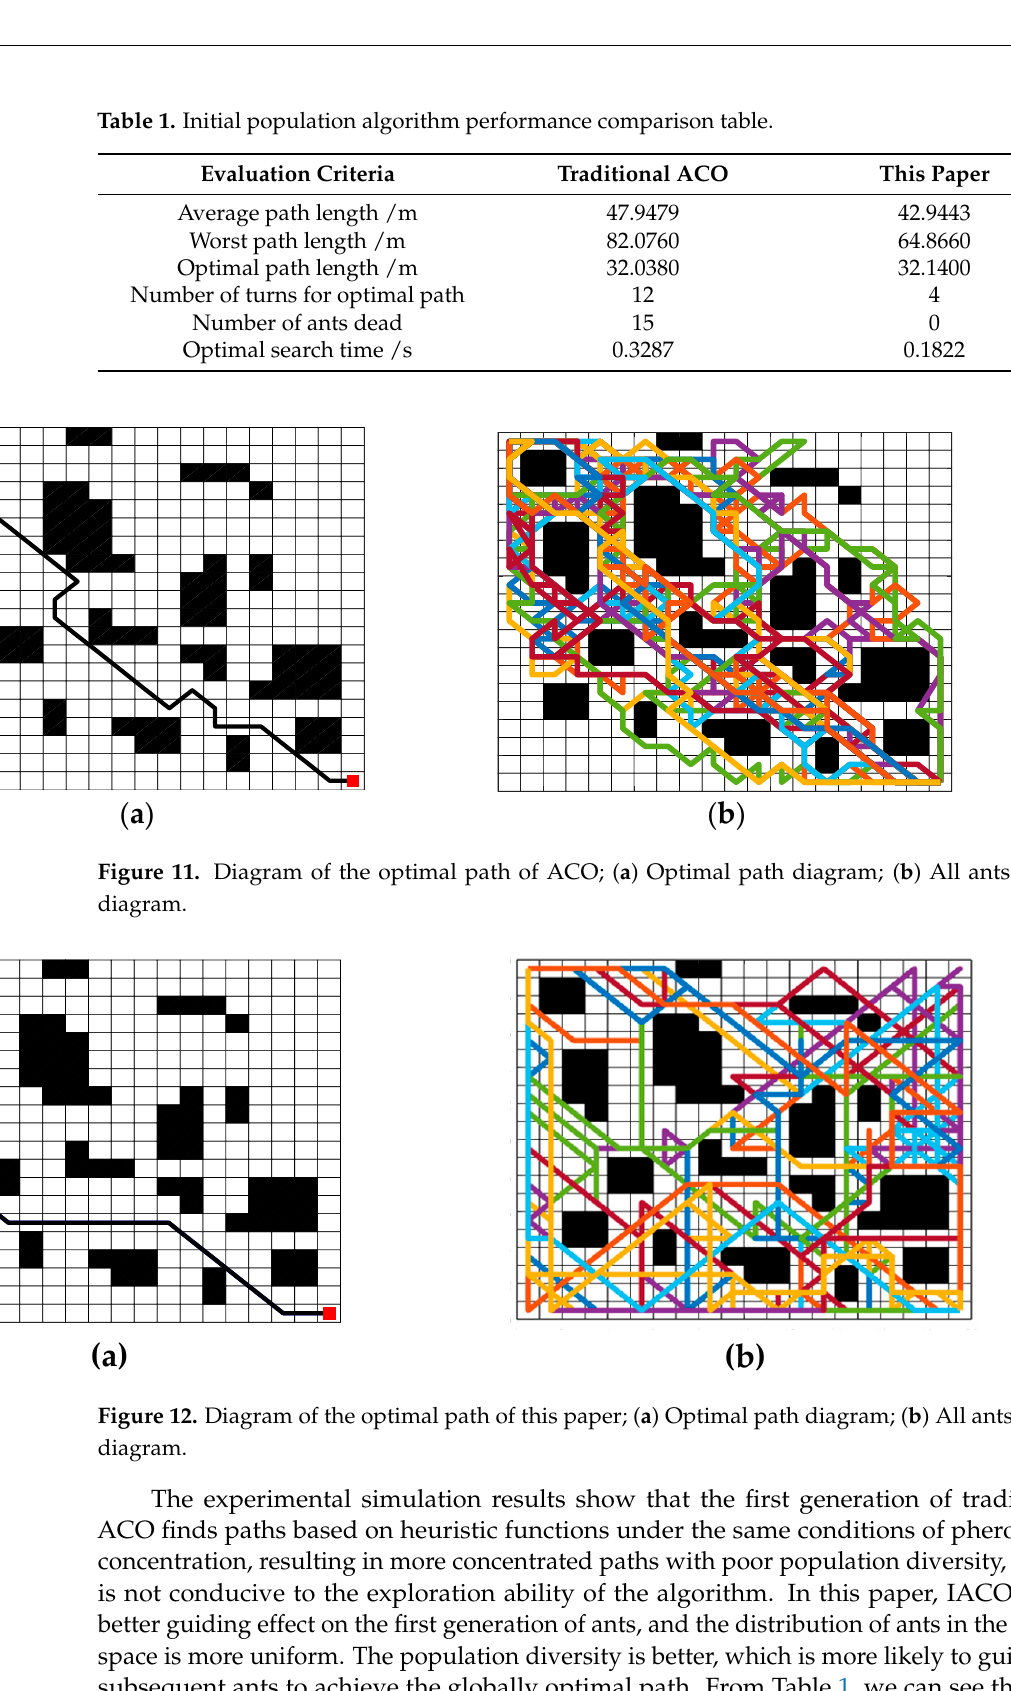
Table 1. Initial population algorithm performance comparison table.